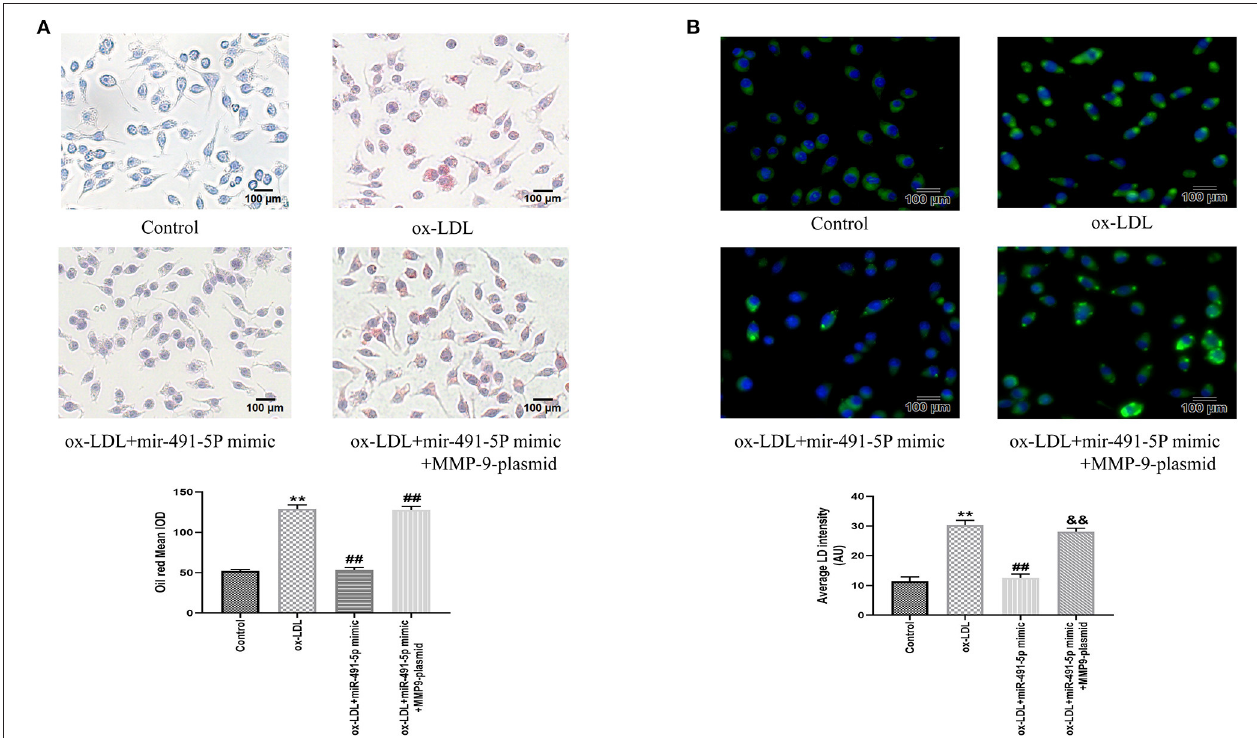
FIGURE 6 | Oil Red O and BODIPY 493/503 staining after mir-491-5P mimic and mir-491-5P mimic + MMP-9-plasmid transfections. (A) THP-1 macrophage cells were transfected before incubation with ox-LDL and staining with Oil Red O ( × 200, 100 µ m), the intracellular lipid droplets of the mean optical density value (mean IOD) were used to reflect the degree of cellular foam. (B) Lipid droplets were labeled with green fluorescence and the nuclei were labeled with DAPI (blue) ( × 200, 100 µ m), average LD intensity was used to quantify the lipid uptake. Data are presented as the mean ± SD, n = 6. Compared with the control group, ** P < 0.01; compared with the ox-LDL group, ## p < 0.01; compared with the ox-LDL+mir-491-5pmimic group, && p <